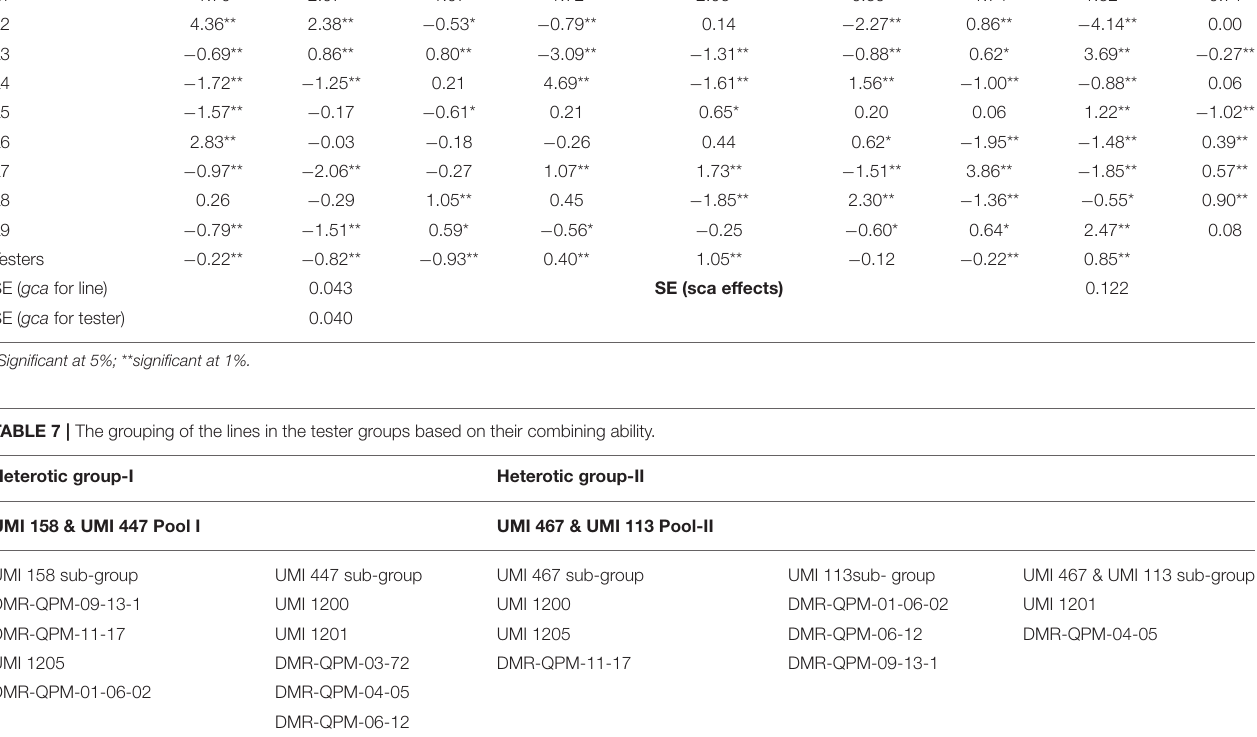
TABLE 6 | General and specific combining ability of parents and hybrids for PA across locations. Phytic acid Lines\Testers